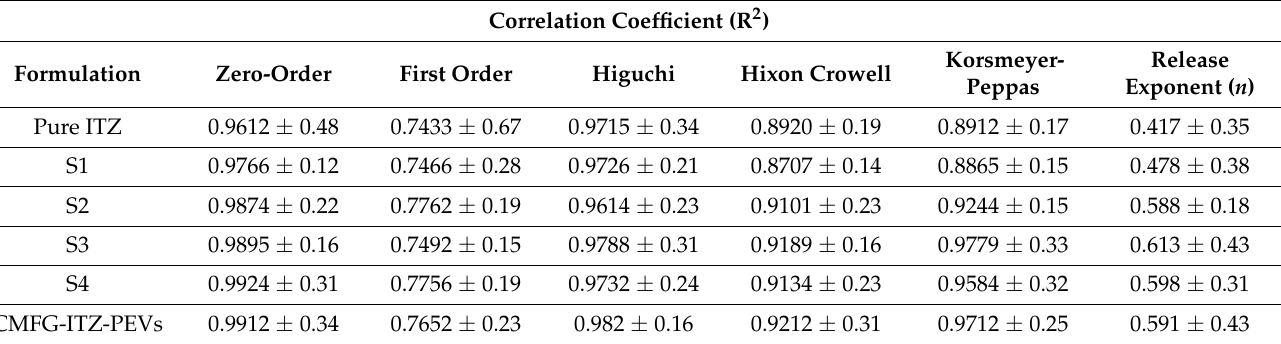
Table 3. In vitro release kinetics of ITZ with various nPEVs and CMFG-ITZ-PEVs (mean ± SD, n = 3). Correlation Coefficient (R 2